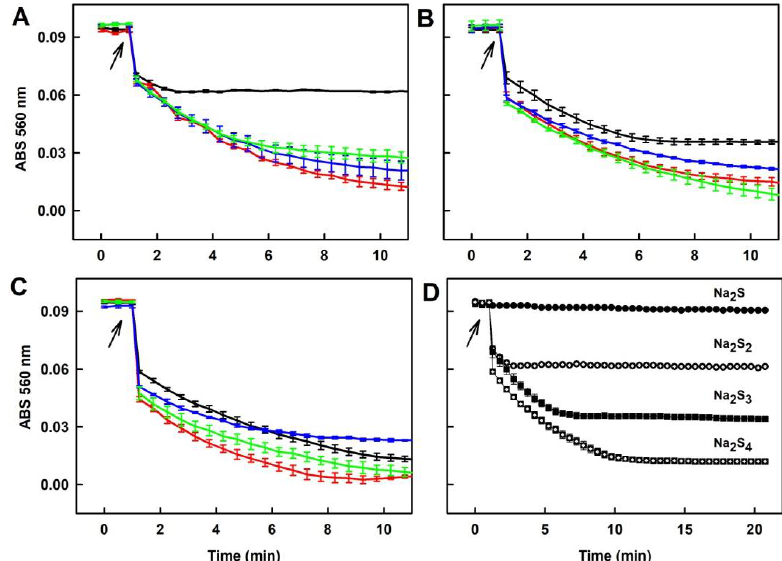
Figure 10. Time-dependent reduction of • cPTIO by the polysulfide/tetracyclines interaction. Kinetics